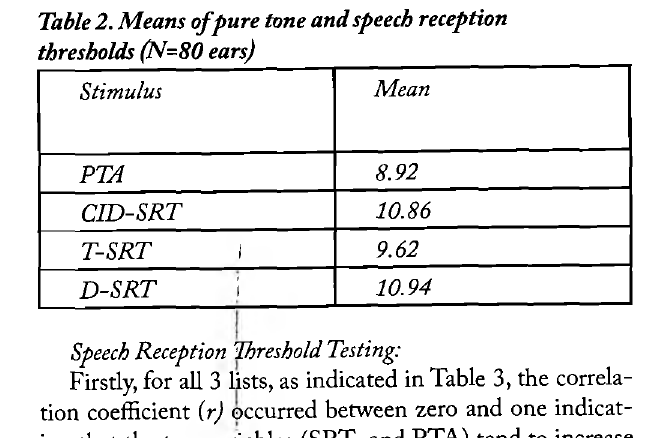
Table 2. Means o f pure tone and speech reception thresholds (N=80 ears)